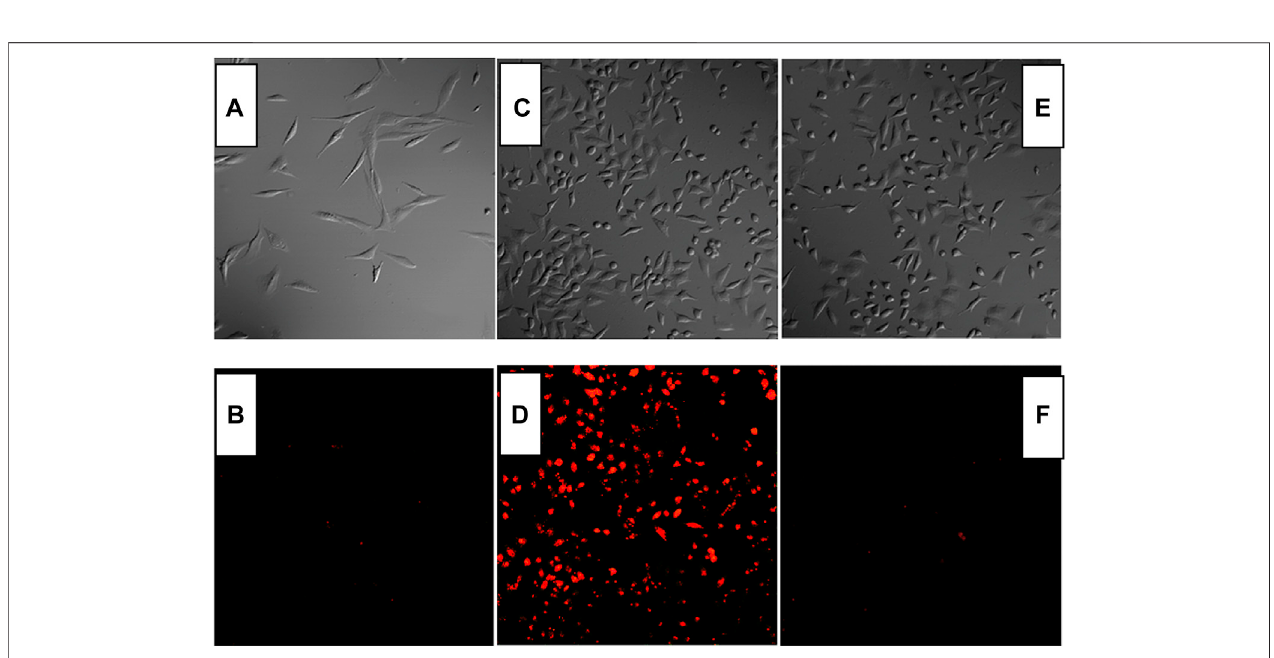
FIGURE 7 | Fluorescent imaging of Rat Schwann cells stained by CS1 (A,B) , CS2 (C,D) , and CS3 [ (E,F) , 10 μ M] without and with Fe 3+ (50 μ M).